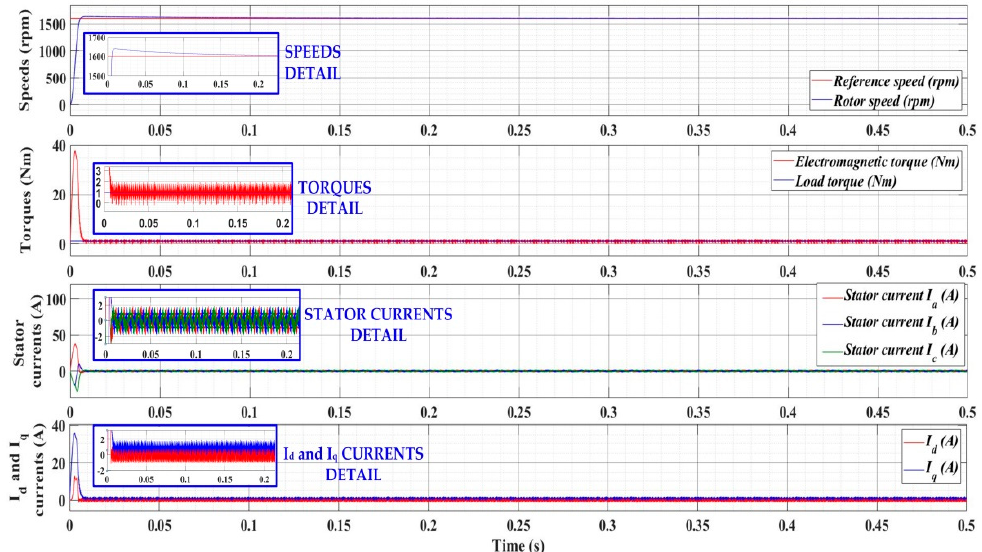
Figure 1. The control system of the PMSM based on the FOC strategy and the PI-PSO speed controller.